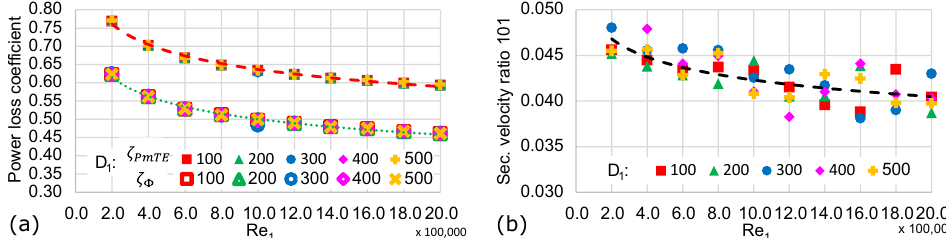
Figure 5. Operating charts of the AxFeeder basic model (part (a) of Figure 3) showing the power loss coefficients ( a ) and the secondary velocity ratio at station 101 ( b ) against the inlet Reynolds